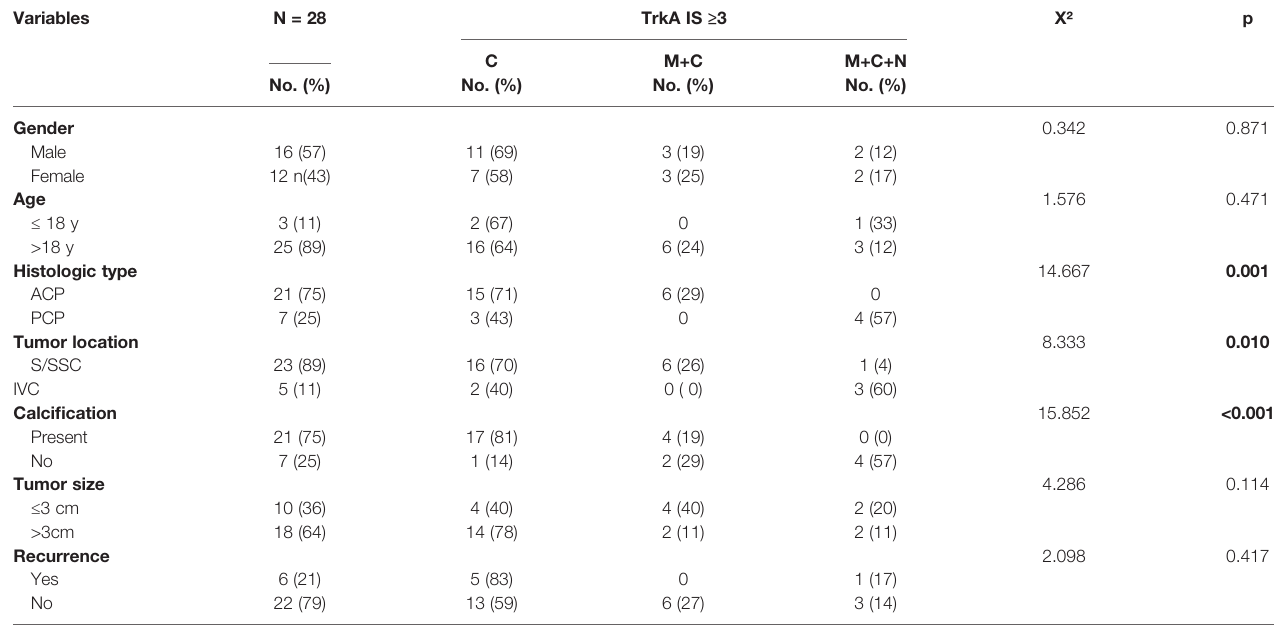
TABLE 2 | The relationship between clinical data and TrkA expression (IS ≥ 3) in craniopharyngioma.